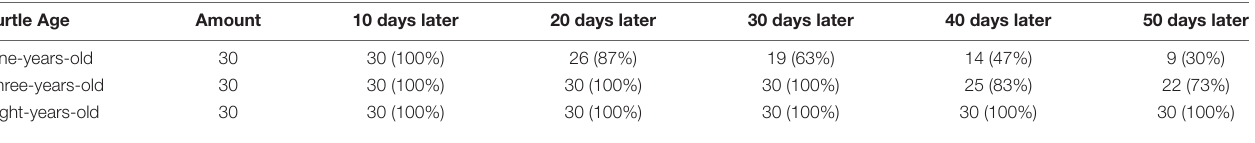
TABLE 2 | Rate of well-pasted QR code stuck with epoxy resin glue in different age turtles. Turtle